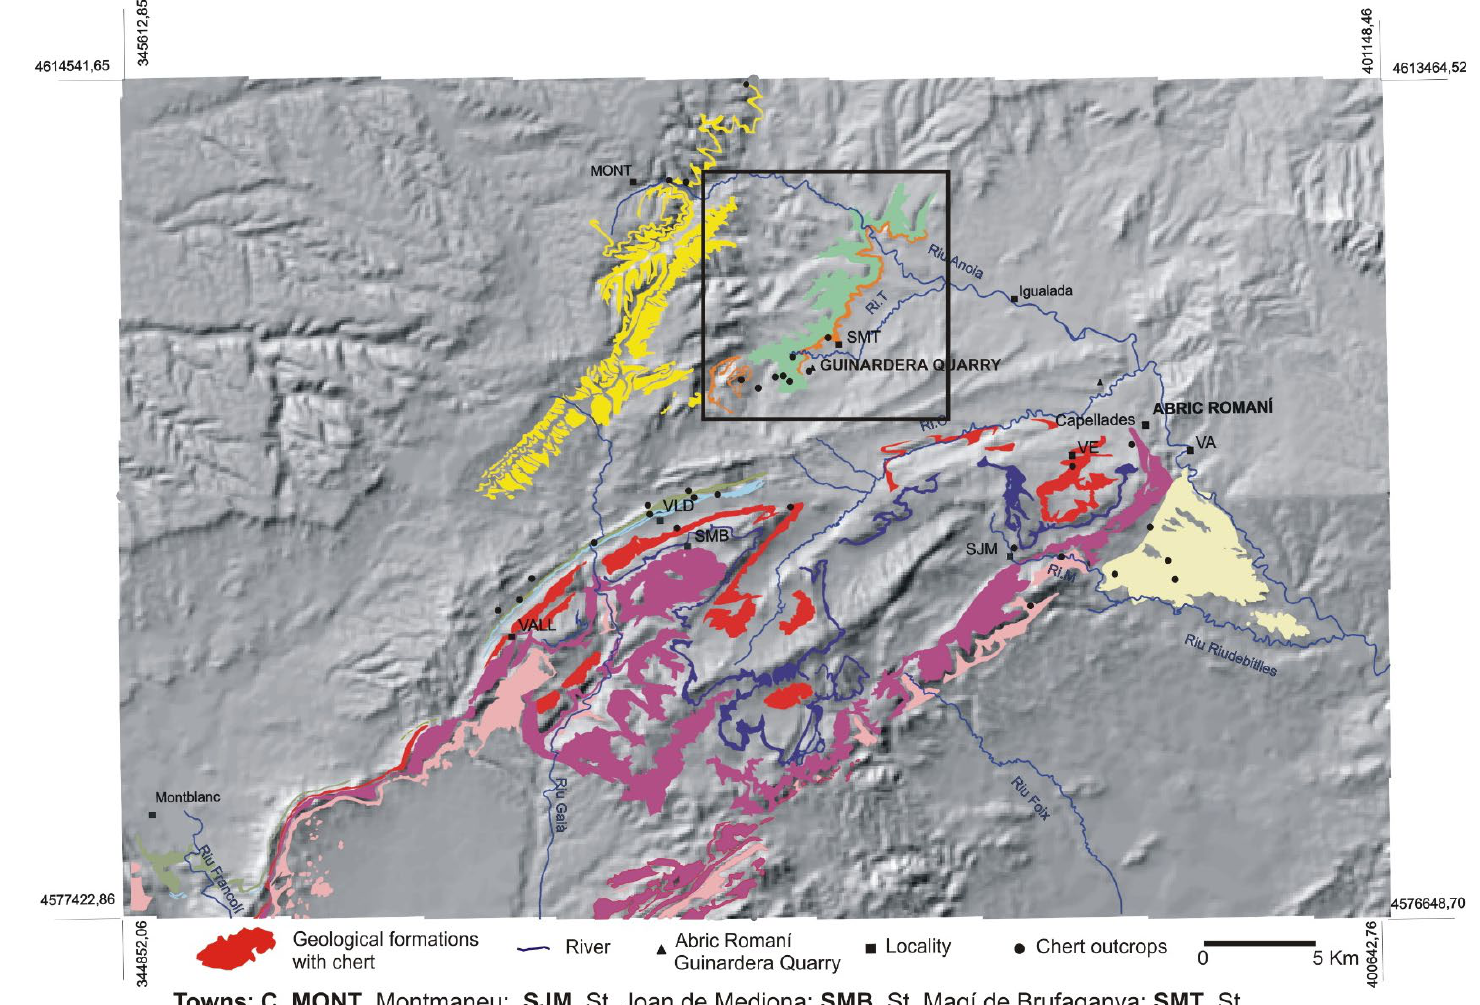
Figure 2. Geological formations containing cherts on the eastern margin of the Ebro Basin and the location of the archaeological site mentioned in the article upon the digital terrain elevation model (1:50,000). In the black box, the Sant Genís formation and the Guniardera Quarry (modified from Gómez de Soler et al.